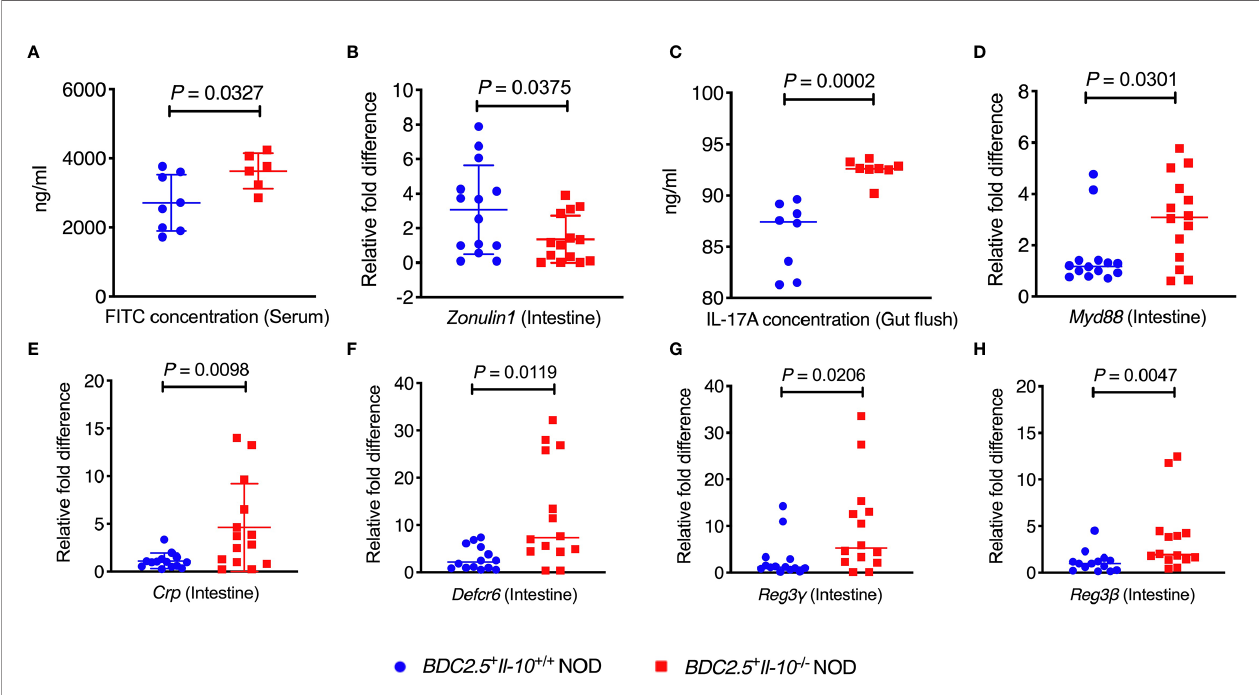
FIGURE 5 | BDC2.5 + Il-10 -/- NOD mice showed altered intestinal responses compared with BDC2.5 + Il-10 +/+ NOD mice. (A) Gut permeability assessed following FITC-dextran uptake into the blood from the gut ( n = 6-8/group). (B) Gene expression of Zonulin1 ( n = 14/group). (C) IL-17A concentration in the gut fl ush of the large intestine ( n = 8/group). (D) Gene expression of Myd88 ( n = 14/group). (E – H) Gene expression of intestinal antimicrobial peptide genes, including Crp (E) , Defcr6 (F) , Reg3 g (G) , and Reg3 b (H) ( n = 14/group). Data in (A – H) were combined from two or more independent experiments are presented as mean ± SD (A, B, E) or Median (C, D, F – H) . Statistical analysis was performed by a two-tailed Student ’ s t -test (A, B, E) or a two-tailed Mann-Whitney test (C, D, F – H) . P < 0.05 was considered statistically signi fi